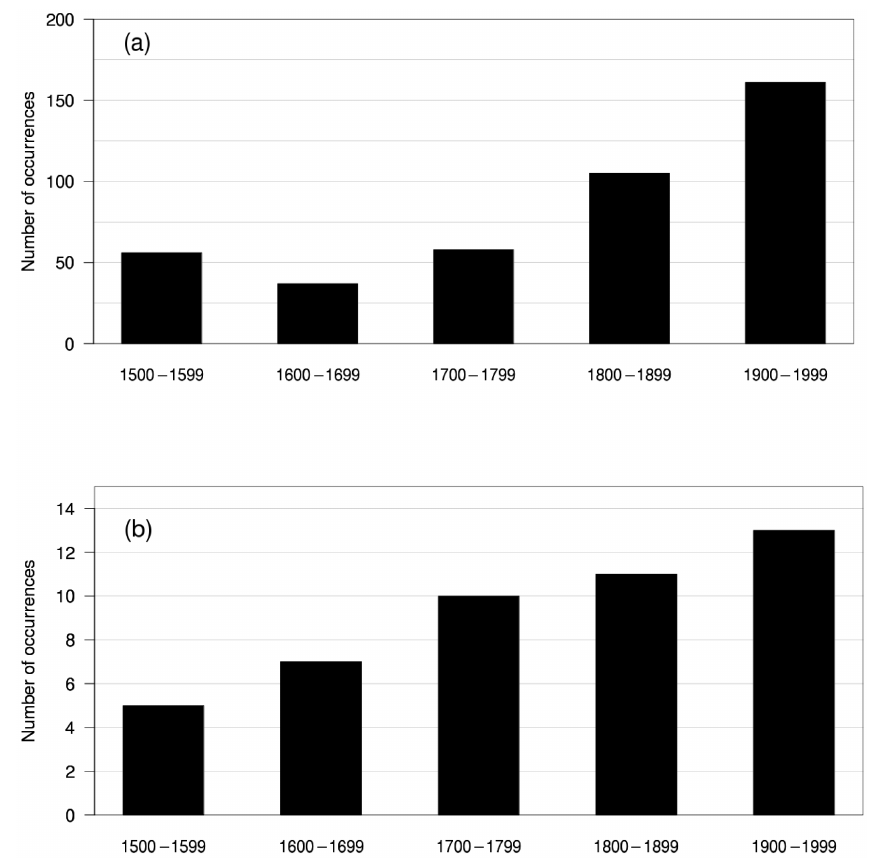
Figure 3. Histogram of storm occurrences per century in Czech Republic from the CZ-Brázdil-500 data set for (a) weaker class 1 and (b) stronger class 2 storms.